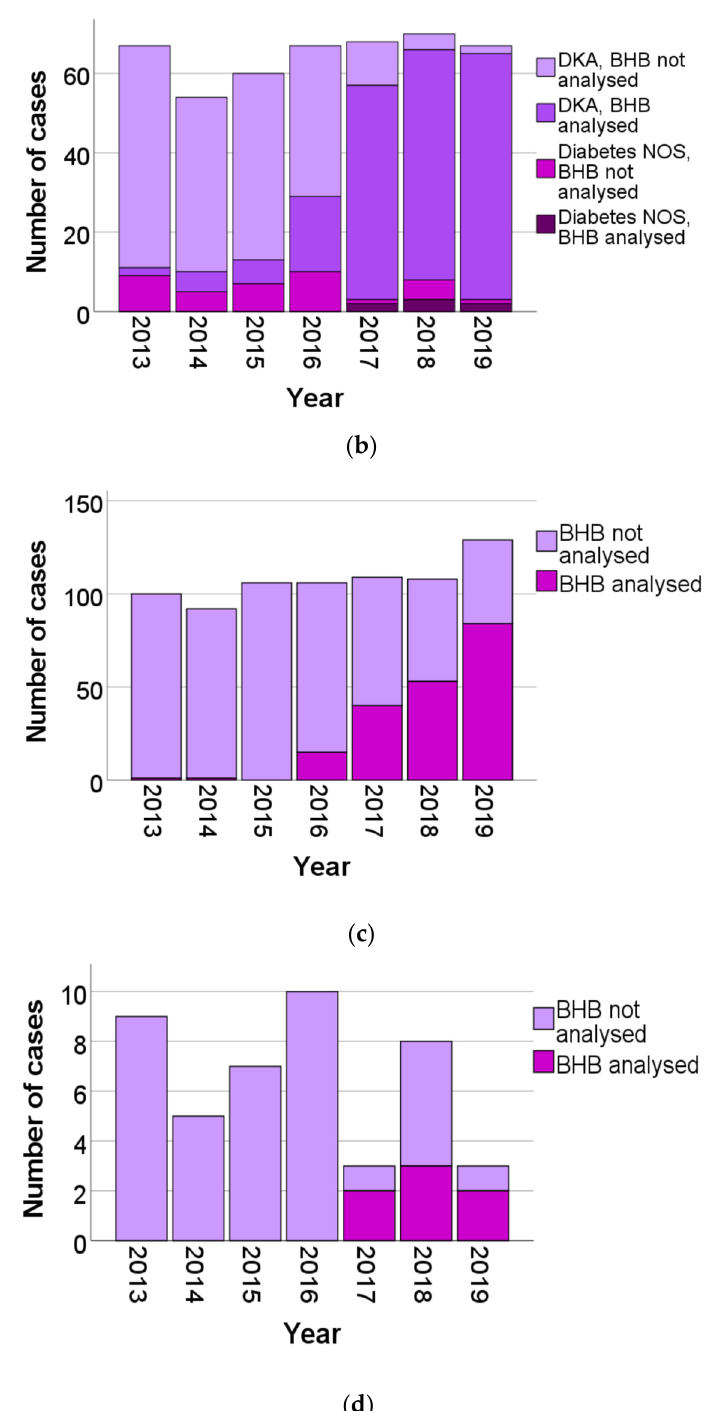
Figure 2. ( a ) Number of AKA (alocoholic ketoacidosis) and chronic alcoholism cases, separated as BHB analysed or not analysed. ( b ) Number of DKA (diabetes ketoacidosis) and diabetes NOS (not otherwise specified) cases, separated as BHB analysed or not analysed. ( c ) Number of chronic alcoholism cases, separated as BHB analysed or not analysed. ( d ) Number of diabetes NOS (not otherwise specified) cases, separated as BHB analysed or not analysed.